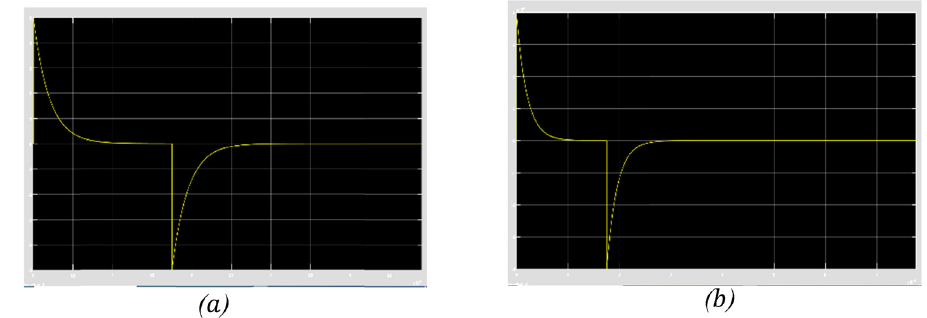
Figure 14: PD calibrated signals from Matlab/Simulink. ( a ) Pulse voltage source ( 40 kV ) . ( b ) Pulse applied ( 5 V